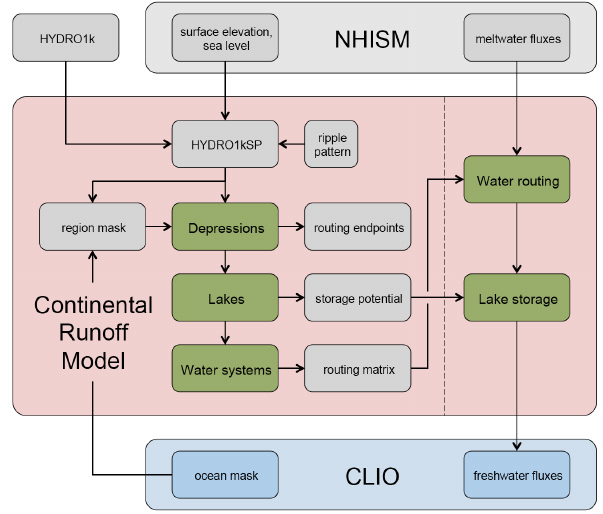
Fig. 1. Overview of the Continental Runoff Model and of exchanges Figure 1: Overview of the Continental Runoff Model and of exchanges with the ice sheet 2 with the ice sheet model (NHISM) and the ocean model (CLIO). model (NHISM) and the ocean model (CLIO). The processing chain on the right hand side 3 The processing chain on the right hand side displays how freshwater displays how freshwater fluxes from the ice sheets are routed to appropriate oceanic grid 4 fluxes from the ice sheets are routed to appropriate oceanic grid cells. 5 cells.